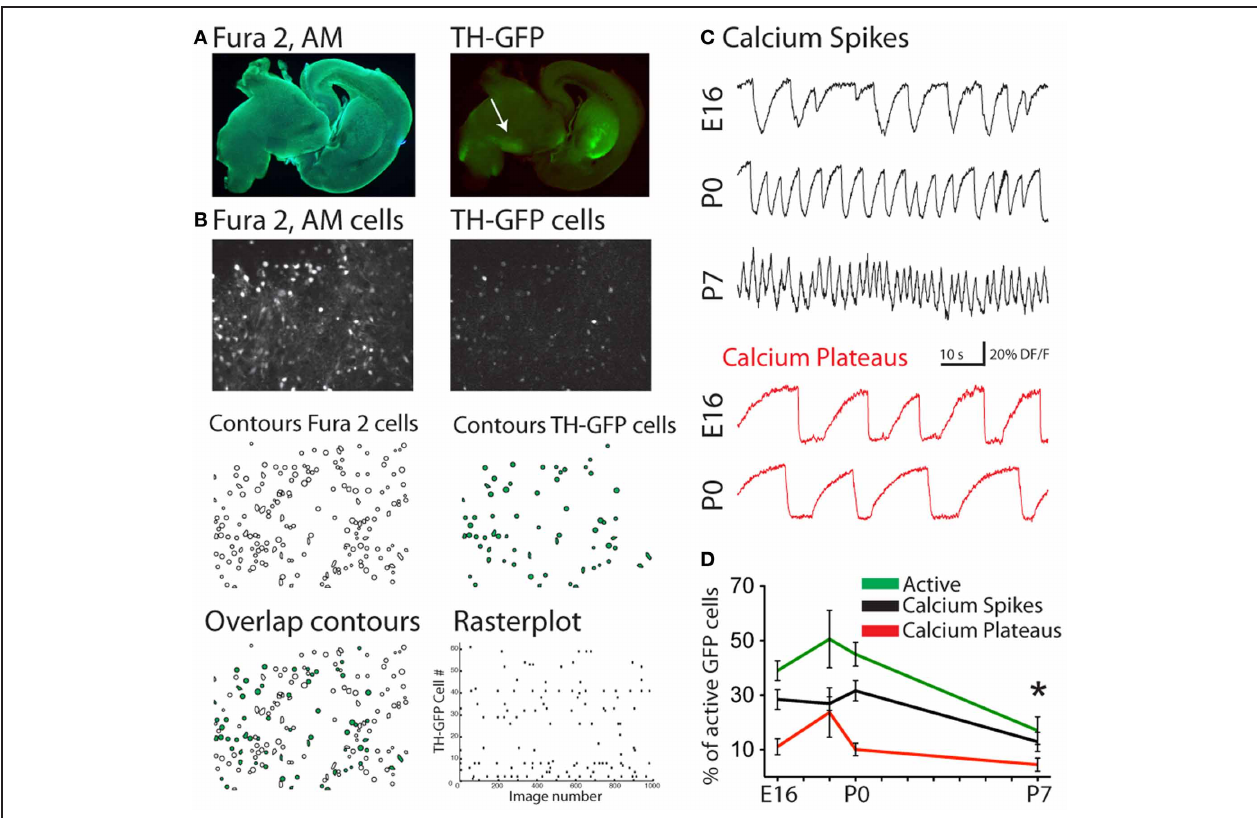
FIGURE 2 | Spontaneous Ca 2 + activities of embryonic and early postnatal mDA neurons. (A) Photomicrograph of the same fura 2-loaded sagittal slice from a P0 TH-GFP mouse excited with UV (left) or blue light (right) to show the slice loaded with the calcium dye fura 2-AM and the location of the GFP-positive structures, respectively. Recordings were performed in the midbrain, in the region of the substantia nigra (SN, white arrow). (B) Fluorescence images of the cells in the same fura 2-loaded (top left) and GFP-positive (top right) SN region. Manually detected contours of the cells from the corresponding fluorescence images (Middle). Superimposition of the two fields (Bottom, left). Open